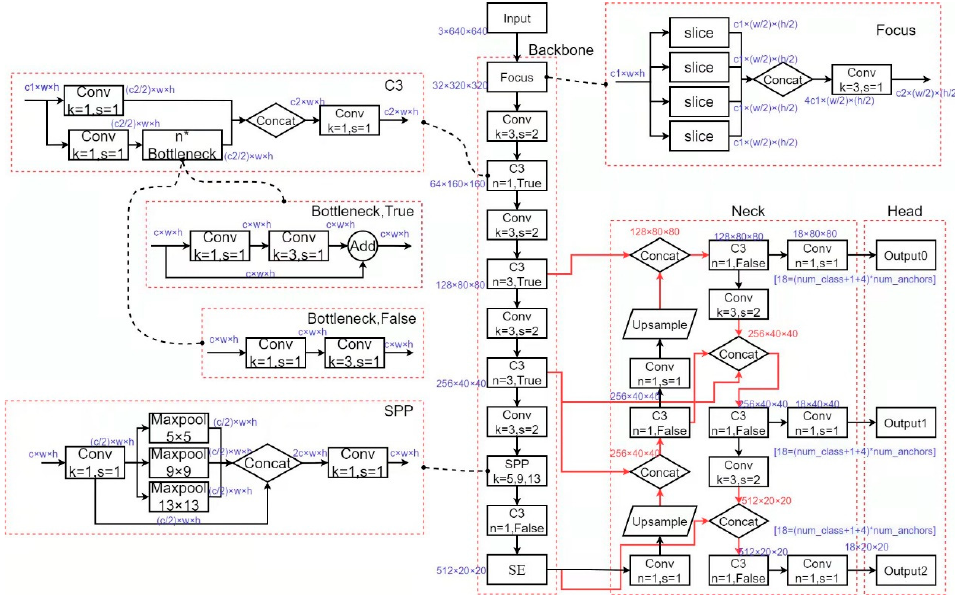
Figure 8. Improved YOLOv5s network structure diagram.